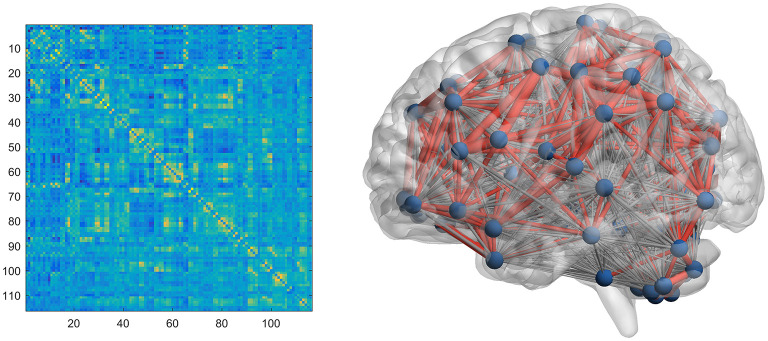
Construction of brain network in the participants.